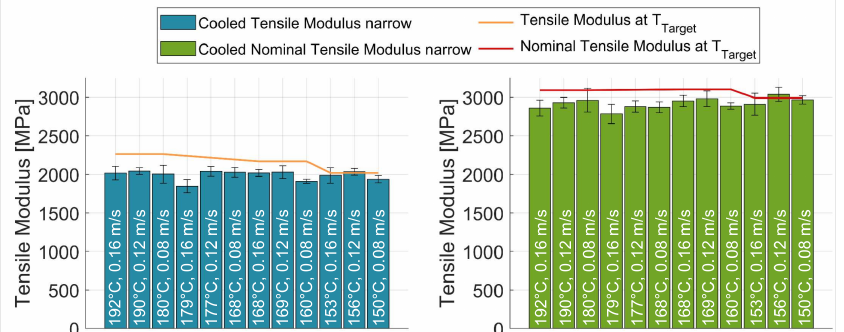
Figure 12. Standard and nominal transverse tensile modulus of the cooled specimens at 100 mm cooling distance with the reference tensile strengths for unheated specimens at the achieved heated